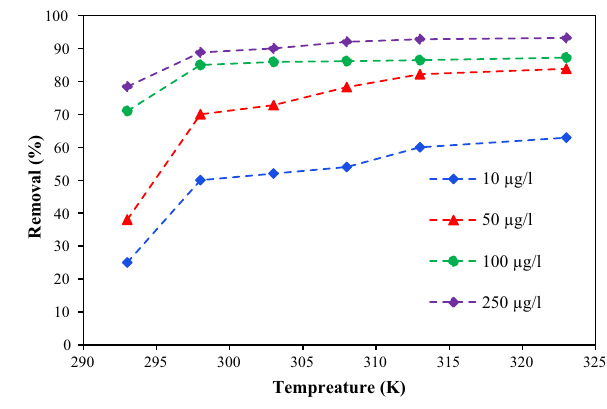
Fig. 3 Effect of contact time and initial concentration on capacity of arsenic adsorption by modified saxaul ash (initial arsenic concentra- tion of 100 µg/L, optimum pH of 7, optimum adsorbent dosage of 1.5 g/L and temperature of 298 K)